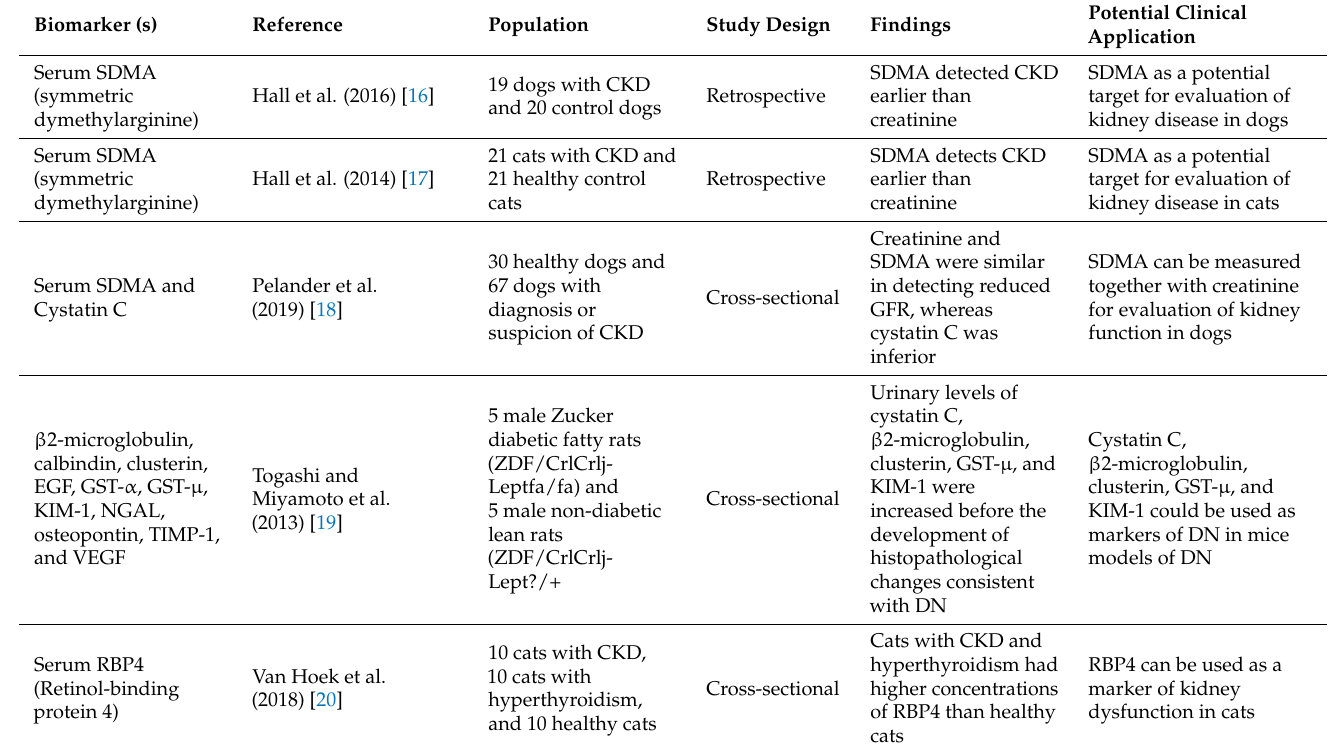
Table 1. Animal experiments published to assess biomarkers and their association with kidney diseases or DN